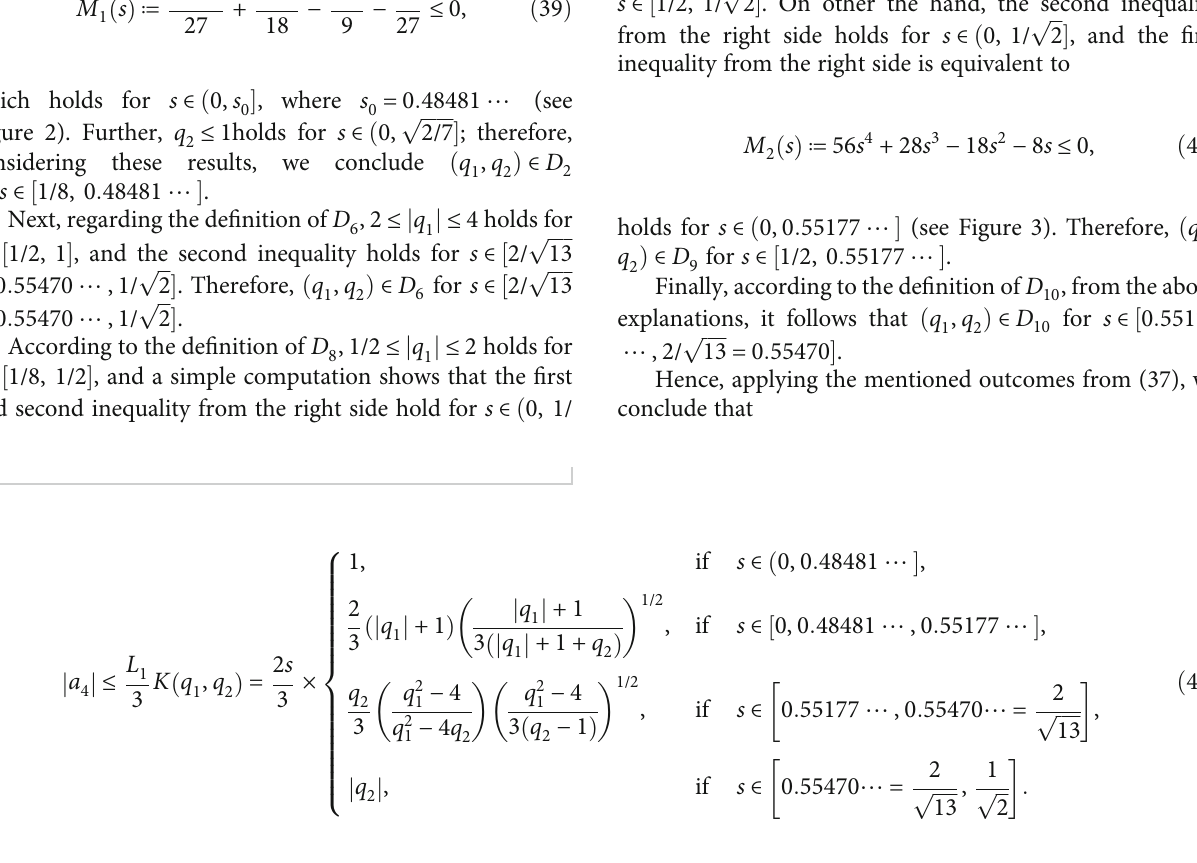
Figure 2: The plot of M ffiffiffi p (cid:2) and s ∈ ½ 0 : 48481 ⋯ , 1/ 2 Þ ∈ D for s ∈ ½ 0 : 48481 ⋯ , 1/2 (cid:2) . q 8 2 ffiffiffi p (cid:2) . On other the hand, the second inequality 2 s ∈ ½ 1/2, 1/